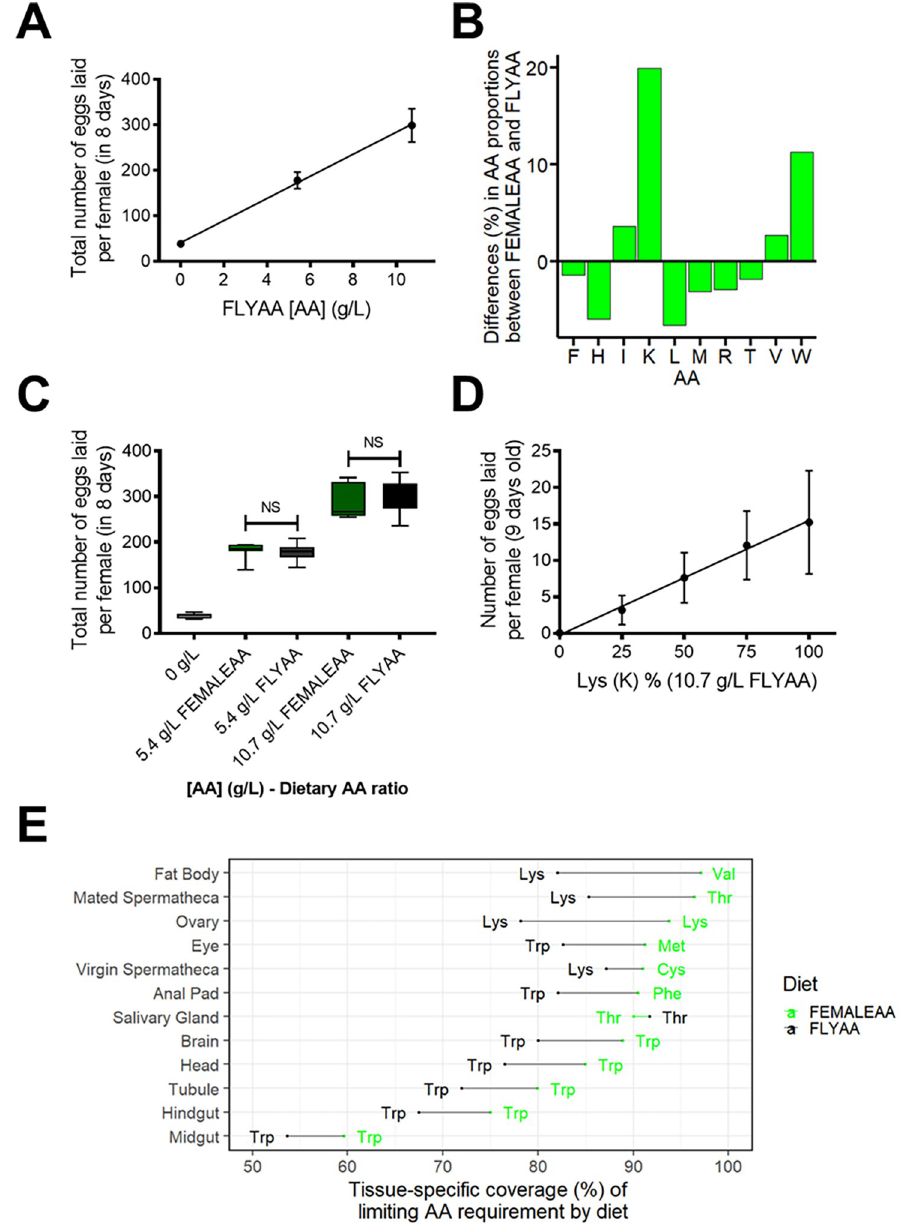
Fig 3. Female fecundity responses to changes in dietary AA ratio and concentration. (A). Total female fecundity showed a linear response to increasing dietary AA concentrations (FLYAA). R 2 = 0.999. (B). Relative change in the molar concentration of each essential AA between the female transcriptome matched diet (FEMALEAA) and the exome matched diet (FLYAA). A positive difference indicates that the AA is more abundant in FEMALEAA than in FLYAA. The relative increase in the concentration of the most limiting essential AA (Lysine, K, 20%) equals the potential increase in fecundity that could be achieved for flies fed with FEMALEAA. (C). At each concentration of total AA, there was no difference in egg-laying output of females fed with transcriptome (FEMALEAA) or exome (FLYAA) matched diets. (D). Lysine dilution limits egg production in a linear manner. Percentages of Lysine concentration are relative to the standard Lysine concentration on FLYAA with a total AA concentration of 10.7 g/L. R2 = 0.995. (E). Coverage of the predicted dietary AA requirements of each tissue in female flies by FEMALEAA and FLYAA. Tissue dietary AA requirements are predicted from the tissue-specific transcriptomes. For each tissue, the x-axis displays the percent of the limiting AA demand covered by the diets FEMALEAA (green) and FLYAA (black). The closer to 100%, the better the diet meets the theoretical tissue AA demand. For all tissues, except the salivary gland, FEMALEAA is predicted to be a better match for requirements than FLYAA. The predicted limiting AA for each tissue on each diet is indicated by the three-letter AA